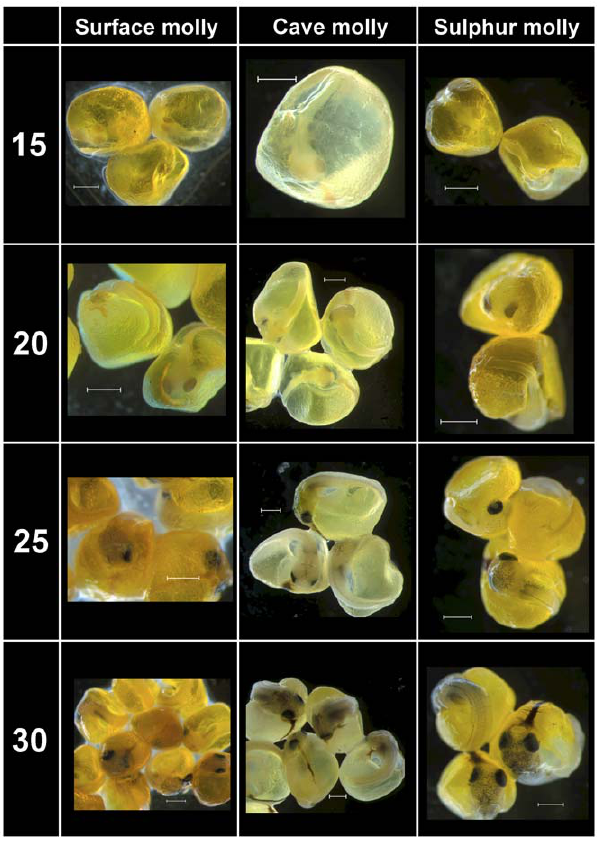
Figure 3. Comparative embryo development of two ecotypes of P.mexicana and of P.sulphuraria . Stages range from Stage 35